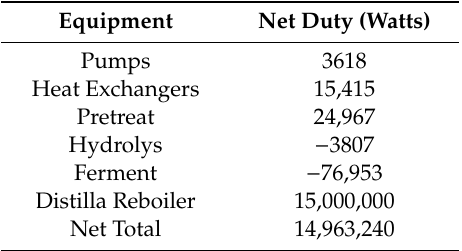
Table 4. Summary of energy requirements in the fermentation